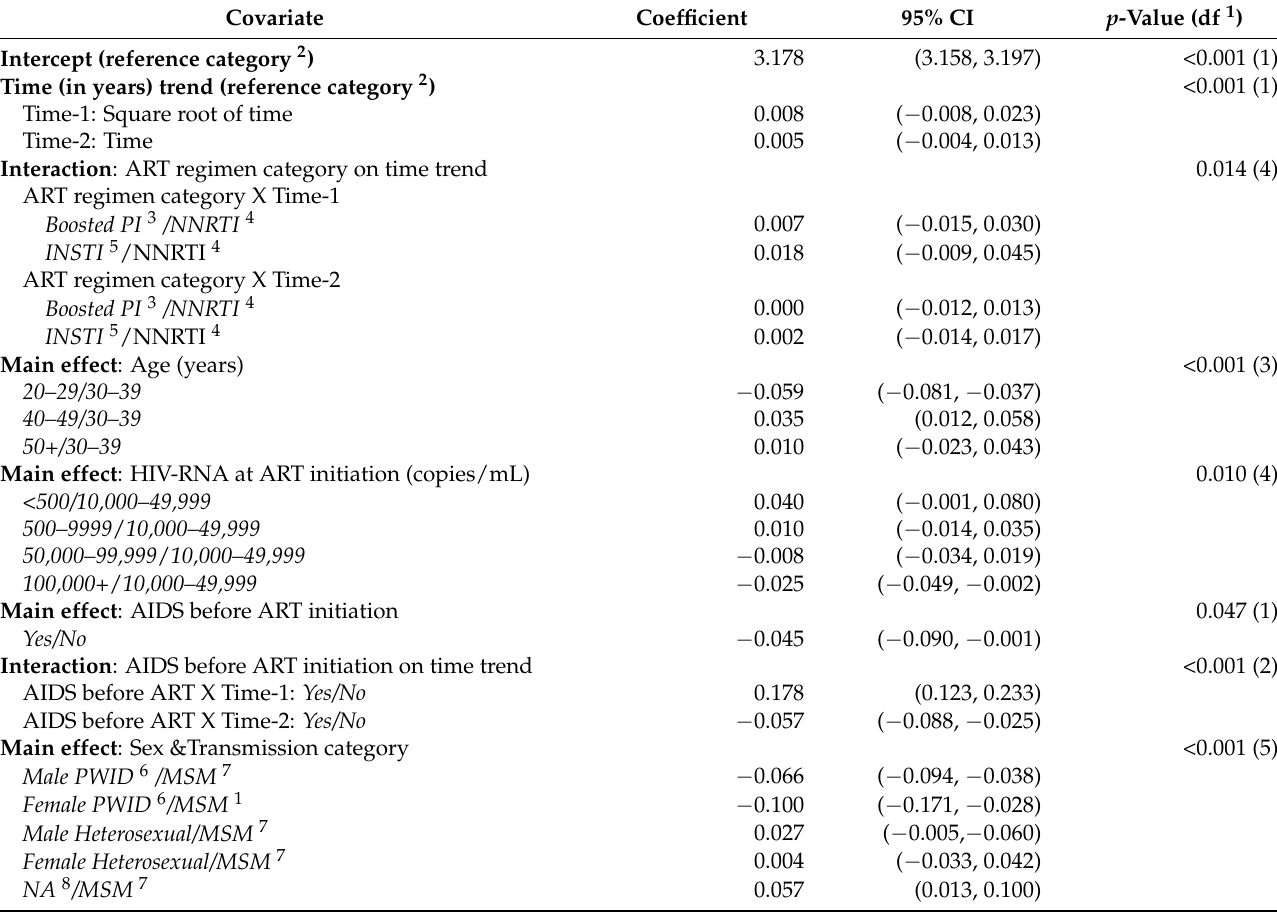
Table 2. Results from the final multivariable linear mixed model for the evolution of body mass index (log transformed) after ART